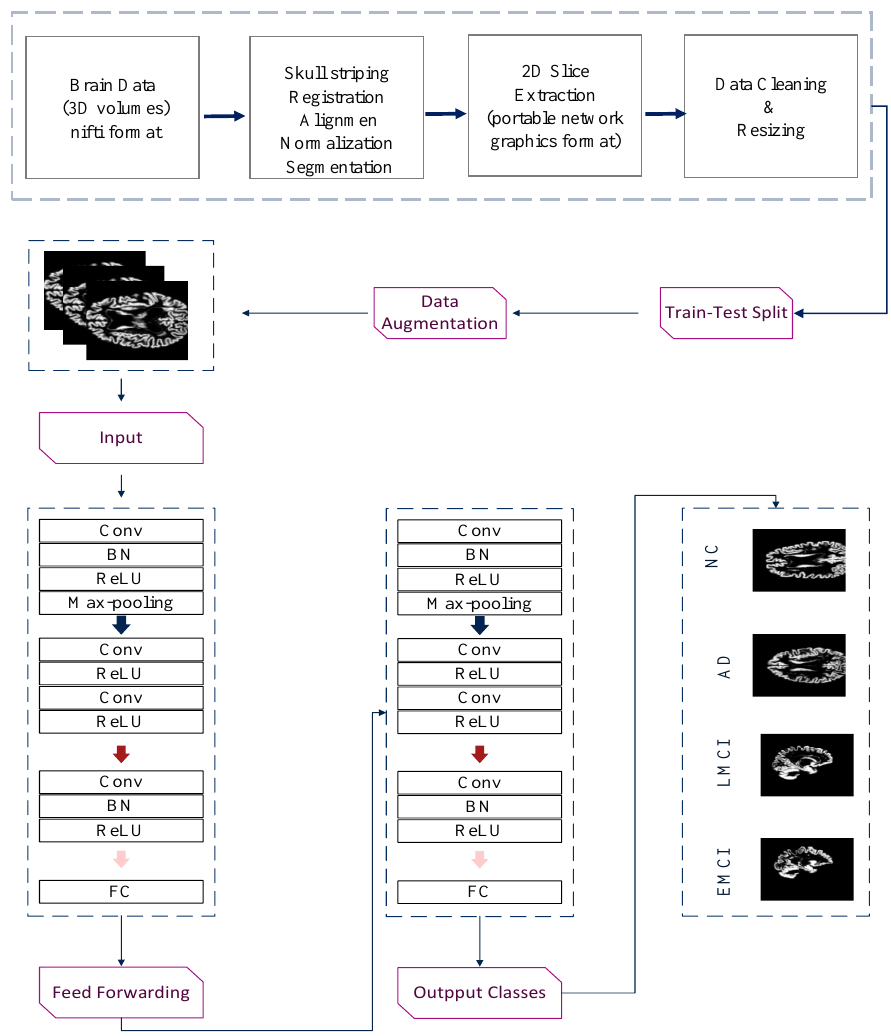
Figure 2. Framework of the proposed framework, with several pre-processing steps, and detailed architecture of the practical multiclass classification network for the diagnosis of Alzheimer’s disease